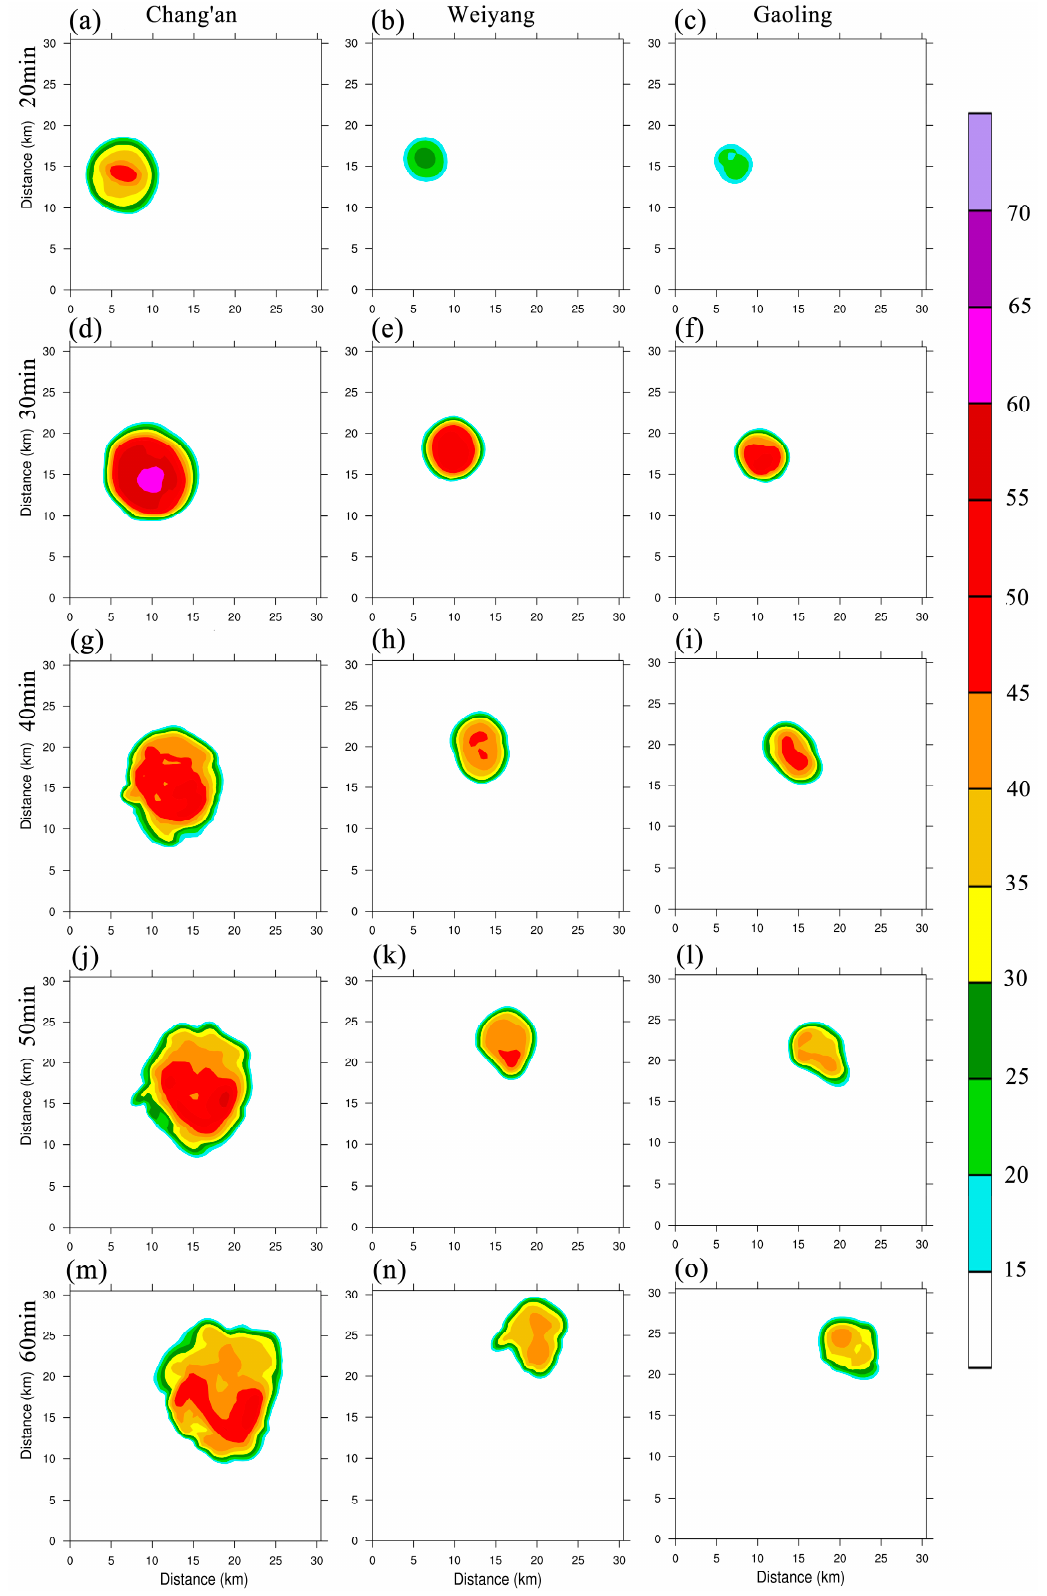
Figure 9. Radar reflectance (dBZ) over the model at 10-min intervals (where ( a – c ) are 20 min, ( d – f ) are 30 min, ( g – i ) are 40 min, ( j – l ) are 50 min, ( m – o ) are 60 min. ( a , d , g , j , m ) are Chang’an District; ( b , e , h , k , n ) are Weiyang District; ( c , f , i , l , o ) are Gaoling District).